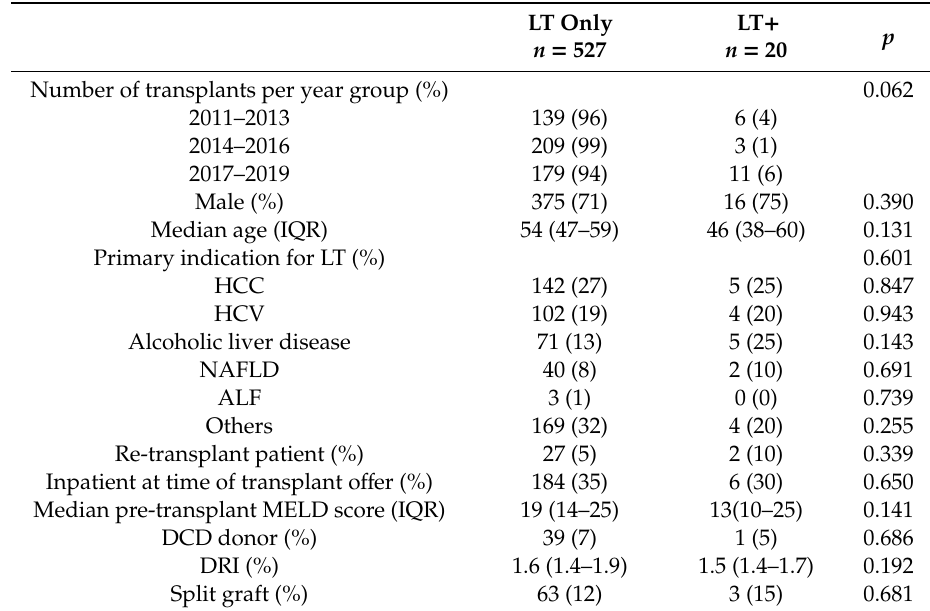
Table 1. Demographic and clinical